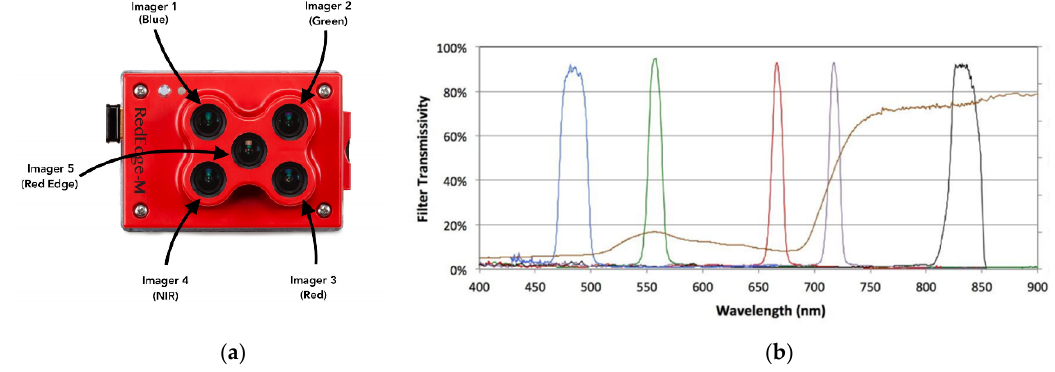
Figure 2. ( a ) Lens configuration of Rededge-M camera and ( b ) the spectral response function of the bands overlaid with a typical vegetation spectrum (source: Rededge-M User Manual).